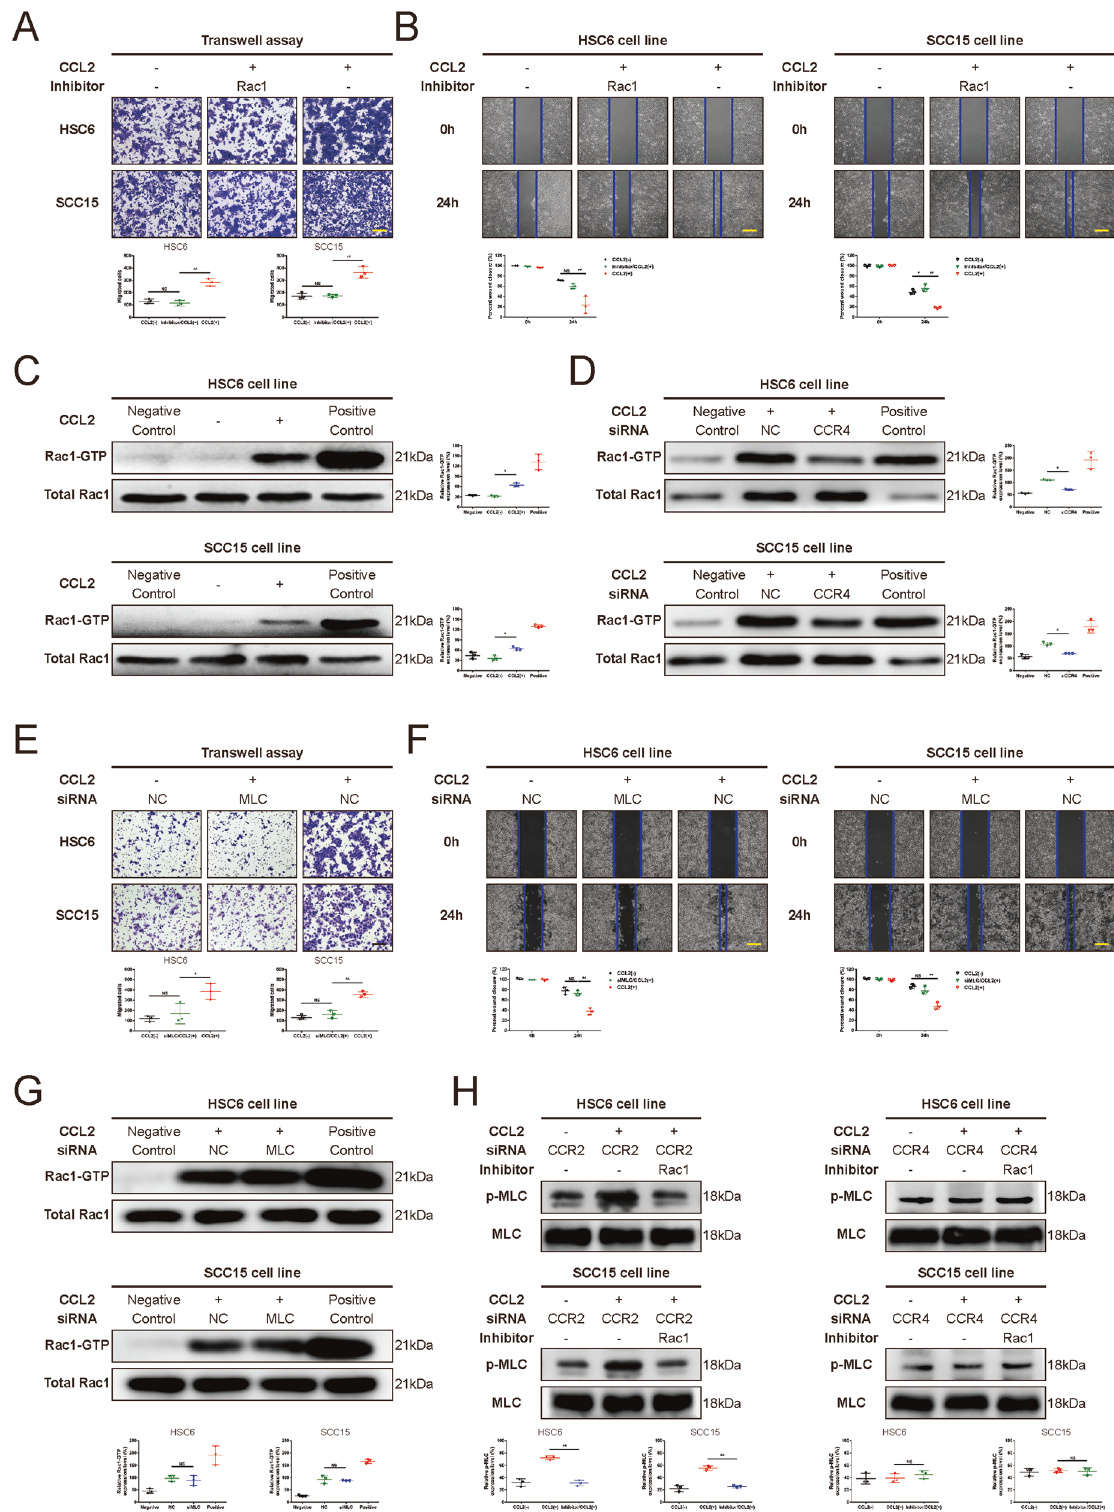
Rac1, a member of the Rac subfamily of Rho-GTPases, is a pleiotropic regulator of multiple cellular processes, including cell motility [27 – 29]. Vav2 had been reported to upregulate cell motility by promoting the cycling between an inactive Rac1-GDP- bound state to an active Rac1-GTP-bound state in many